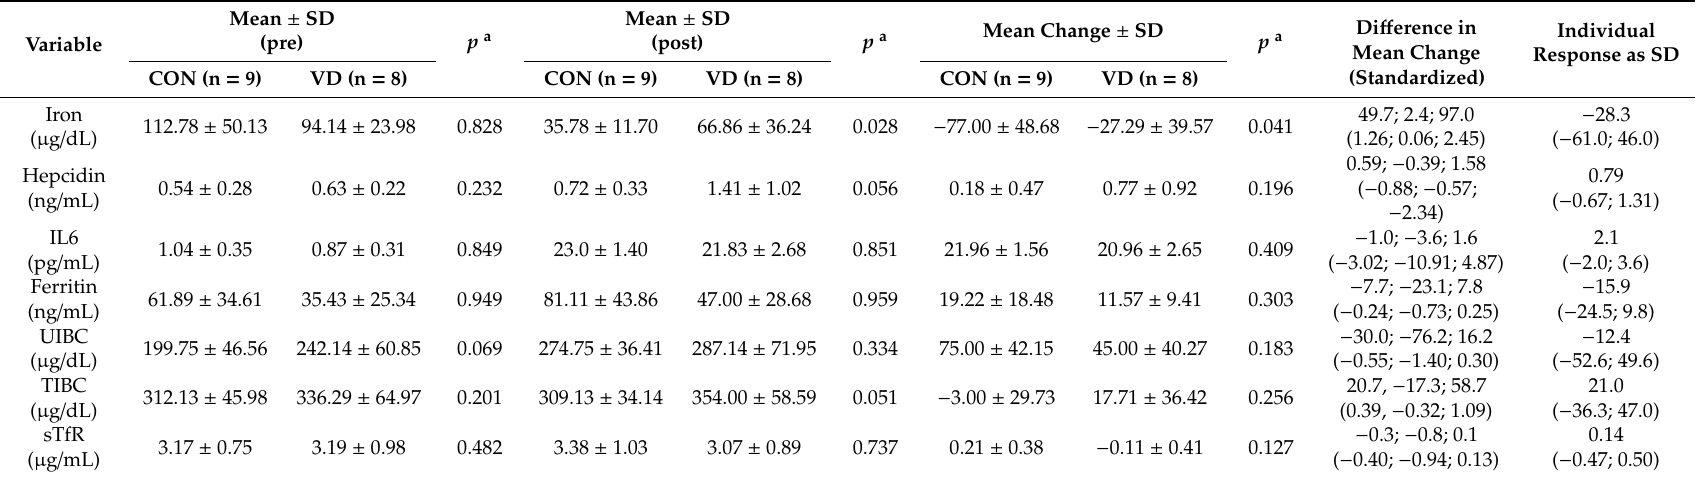
ff erence in mean change and standardized (with pre-running SD) di ff erence in 3 ; for the di